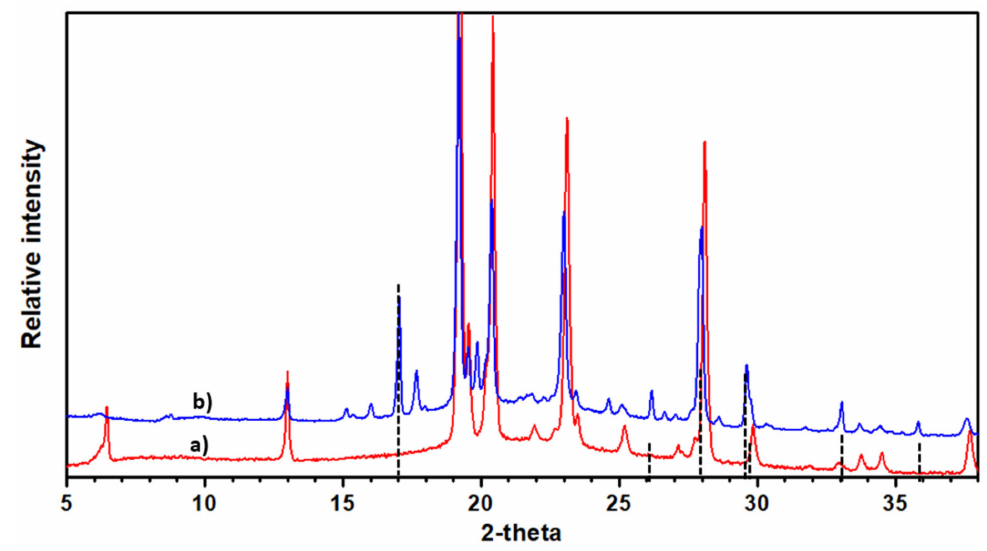
Figure 2. The φ 3-Na pattern (spectrum a ) when compared with the pristine material (spectrum b ). NaNH 2 impurity is indicated as vertical markers. Lines are indexed according to the space group and the cell parameters given in the text for the Na-doped terphenyl. Table 1. The cell parameter refinement of Na-doped